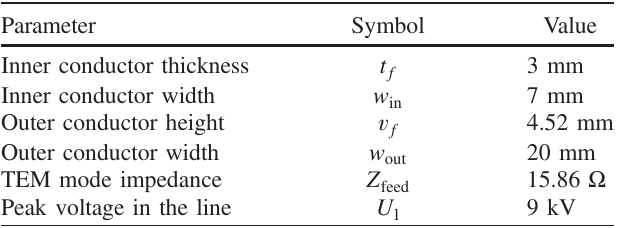
TABLE II. Parameters of the feeding stripline in Fig. 3(b).